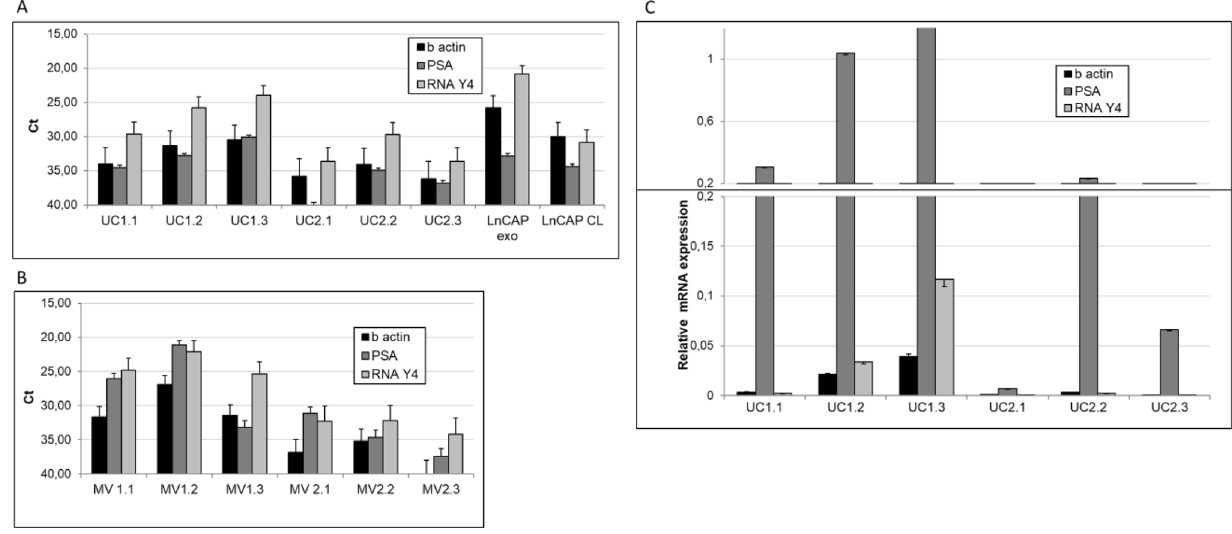
Figure 8. Detection of urine EV-mRNAs by RT-qPCR in longitudinal samples. Following ultracentrifugation, total RNA has been extracted from EV (UC) and MV pellets and RT-qPCR amplification of mRNAs of interest performed as described. Purification is performed on urine obtained from two healthy volunteers, one female (marked as 1) and one male (marked as 2), 45 and 43 years old, in 3 subsequent days. For each sample two aliquots of urine were processed independently and results presented as averages + SD. The results are shown both as Ct values (on the left) and as relative RNA expression (on the right) calculated as delta Ct versus reference sample (RNA extracted from Prostate Cancer LnCAP cell line